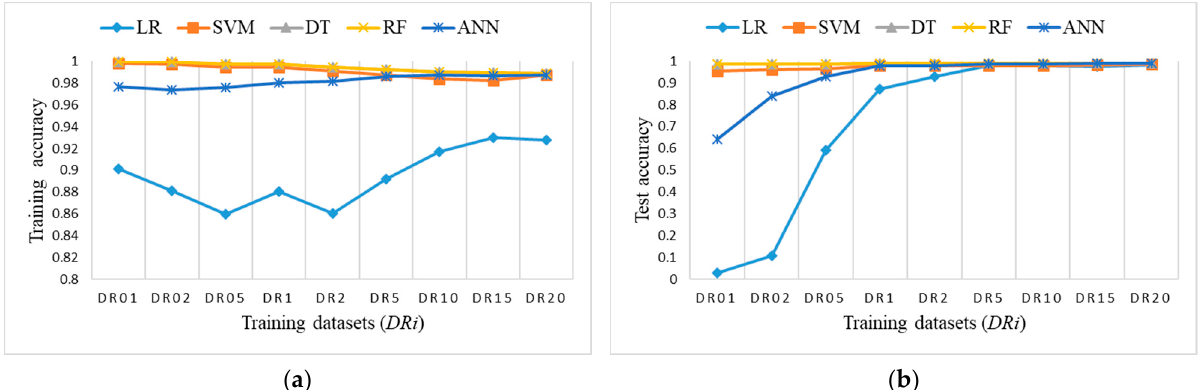
Figure 11. Accuracy measure for ML algorithms on balanced training datasets DRi : ( a ) training accuracy (coincidence of RF, SVM, and DT); ( b ) test accuracy (coincidence of RF and DT).